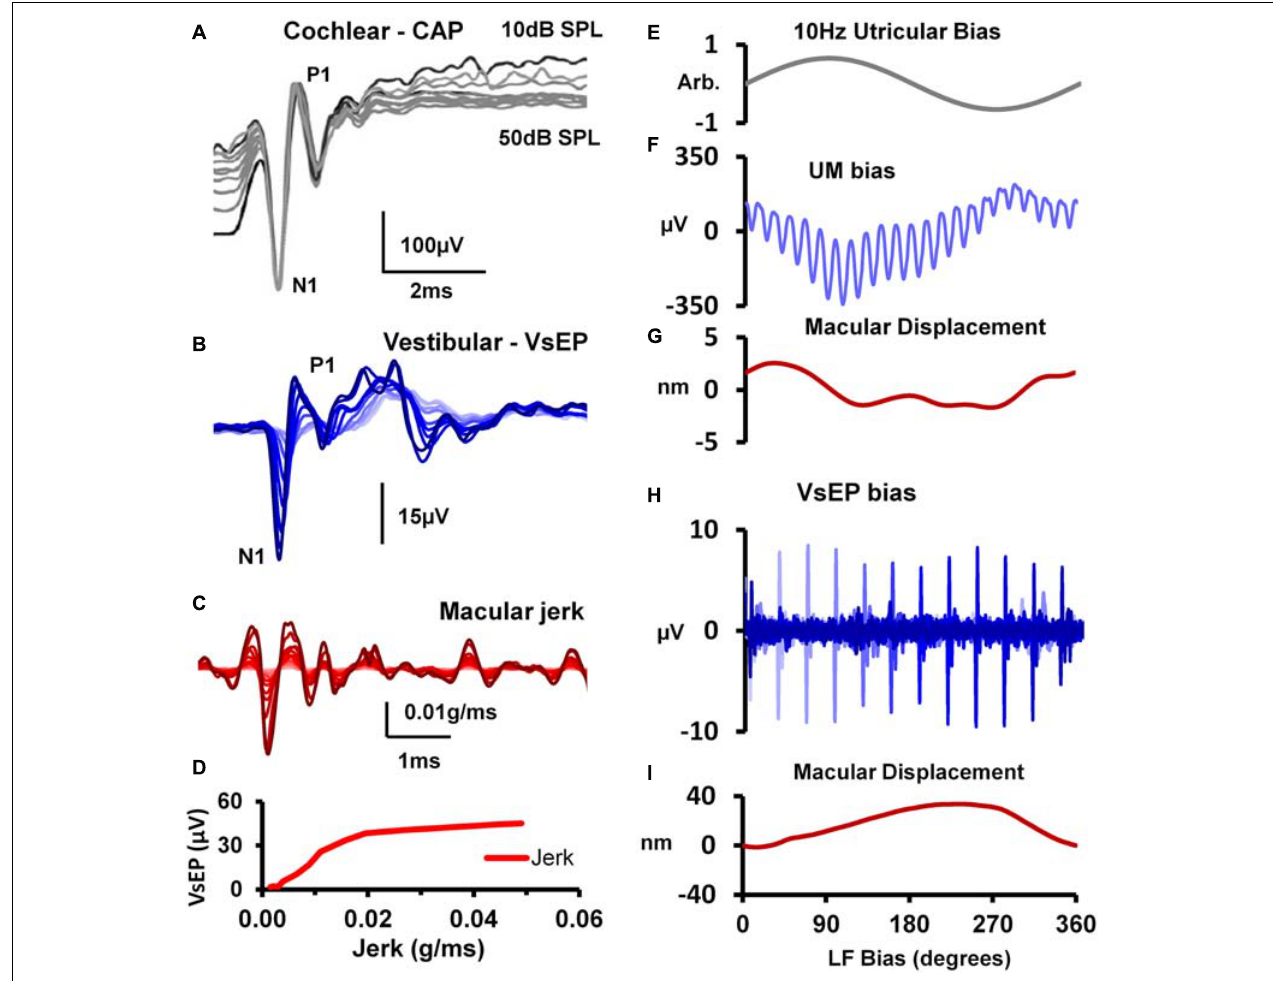
FIGURE 9 | (A) Cochlear nerve CAPs evoked by an 18 kHz, 10 ms tone-burst over a 50 dB sound level range above the CAP detection threshold (in 5 dB steps), showing that the amplitude of the N1 potential is unchanged despite such a large change in stimulus intensity. Reproduced (adapted) from ‘Origins and use of the stochastic and sound-evoked extracellular activity of the auditory nerve’. Pg. 153. Doctoral Thesis. The University of Western Australia. Daniel Brown. 2006. With permission from Copyright owner Daniel Brown. (B) VsEPs evoked by a 0.6ms BCV pulse (0.3ms rise-fall time) over a 25 dB attenuation range. (C) Simultaneous measures of utricular macular jerk (integrated from LDV measures of macular velocity). (D) Input-output function for VsEP N1-P1 amplitude against peak-peak macular jerk. Reproduced (adapted) from Pastras et al. (2018) Copyright Elsevier (Hearing Research). 10x more macular displacement is required to modulate the sensitivity of the VsEP compared to the UM. (E) 10 Hz hydrodynamic bias of the utricular macula delivered via a fluid-filled pipette sealed into the horizontal semicircular canal (hSCC). (F) Cyclic modulation of the UM amplitude evoked by 220 Hz BCV over 1 cycle of the 10 Hz bias (100 ms), and (G) the corresponding level of macular displacement. (H) Cyclic modulation of the VsEP evoked by a 1ms BCV pulse over 1 cycle of the 10 Hz bias, and (I) the associated macular displacement. Adapted from Pastras et al. (2020) Copyright